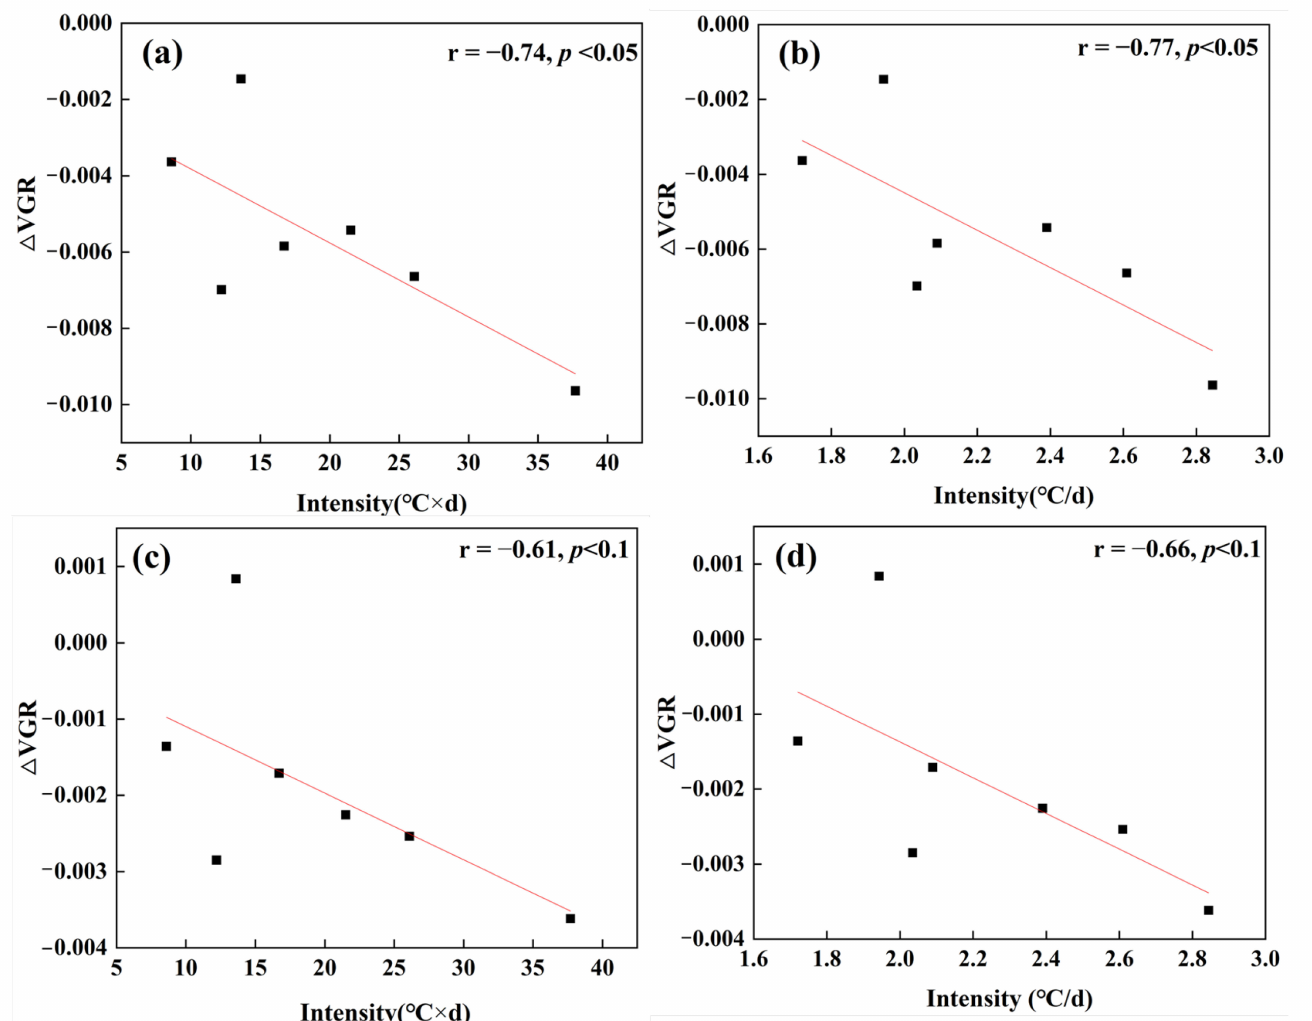
Figure 7. Pearson’s correlation coefficient between the intensity of the heatwave and the ∆ VGR from June to August during the growing season for all 64 sites on the Tibetan Plateau. ( a , c ) the accumulative intensity of heatwaves versus the ∆ VGR. ( b , d ) the average intensity of heatwaves versus the ∆ VGR. The ∆ VGR in ( a , b ) is calculated from NDVI, and in ( c , d ) is calculated from